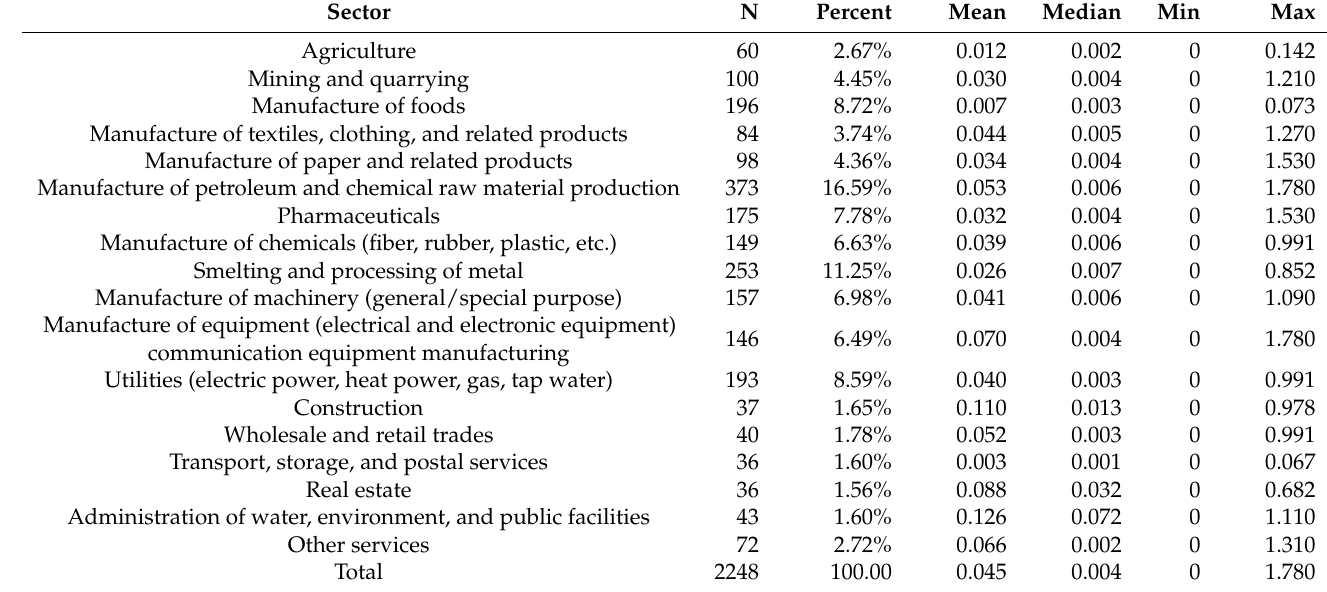
Table 3. Descriptive statistics of industry characteristics of the enterprises’